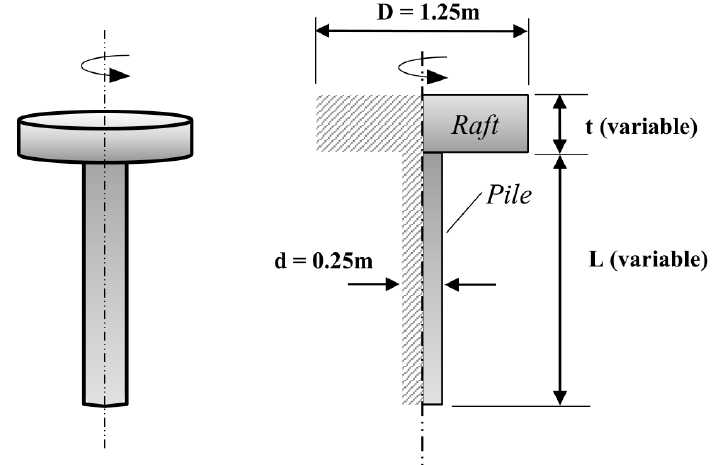
Figure 6. Geometry of the piled